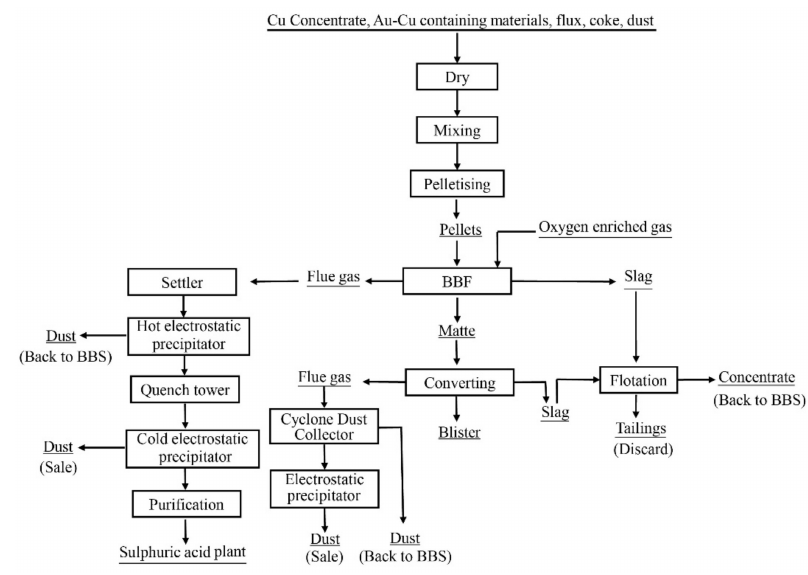
Figure 1. Flowsheet of SKS copper smelting technology, adapted from [16]. Table 1. Detailed operating parameters during SKS trial. Data derived from